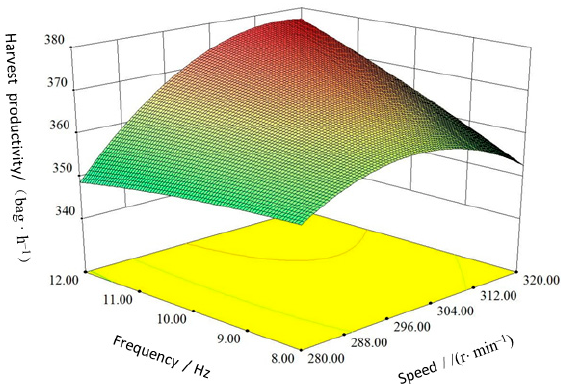
Figure 5. Y 1 = ( A , B , 0). Response surfaces of tray speed and harvesting knife frequency on harvest Figure 5. Y 1 =( A , B ,0). Responsesurfacesoftrayspeedandharvestingknifefrequencyonharvestproductivity. productivity.